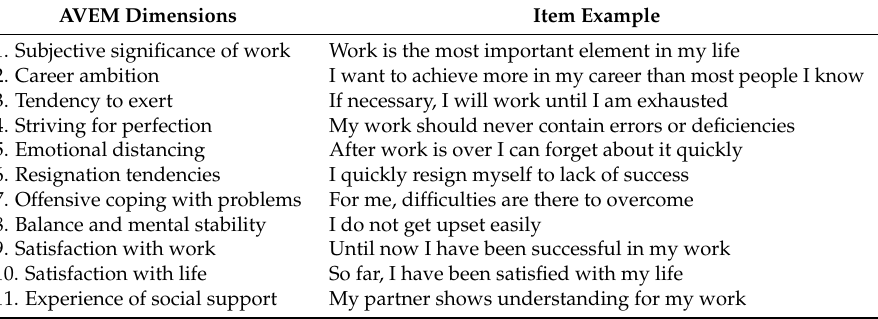
AVEM Dimensions Item